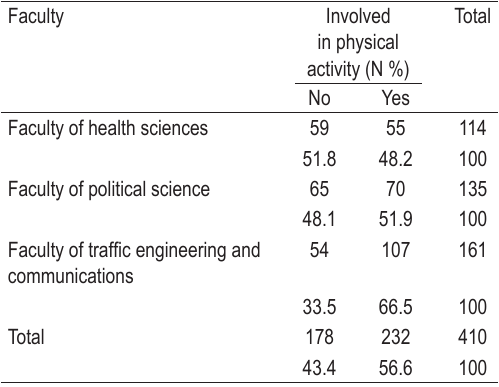
TABLE 4. Prevalence of physical activity (recreational or active sport) among students in three